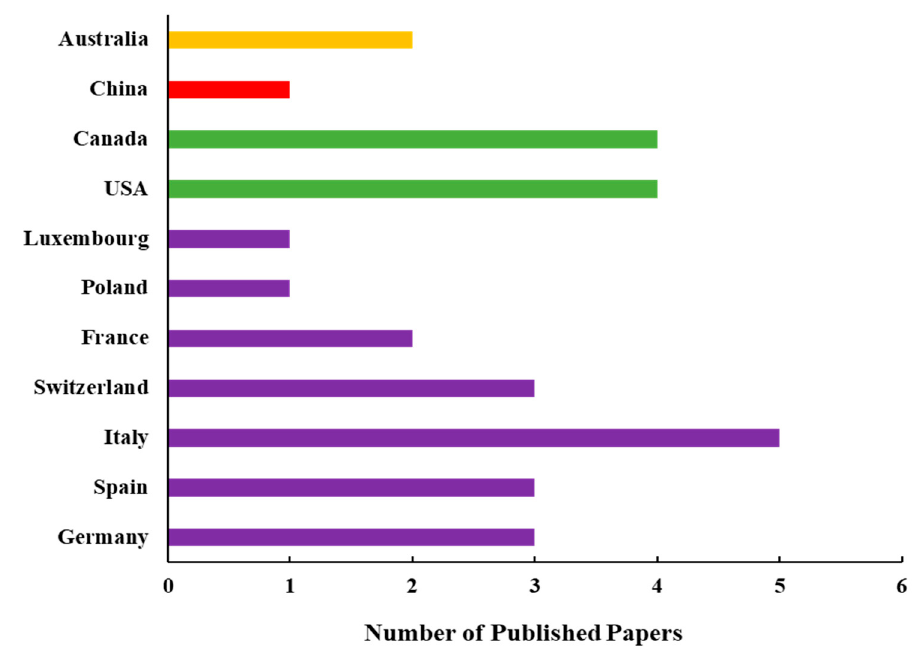
Figure 3. Bar graphs represent the country-wise airborne SIF studies published until 2019. The color of each bar represents different continents (Yellow = Australia, Red = Asia, Green = North America, Violet = Europe). Note: the first author and/or corresponding author (if different) affiliations were used as the main criterion in defining the country of origin of the paper.